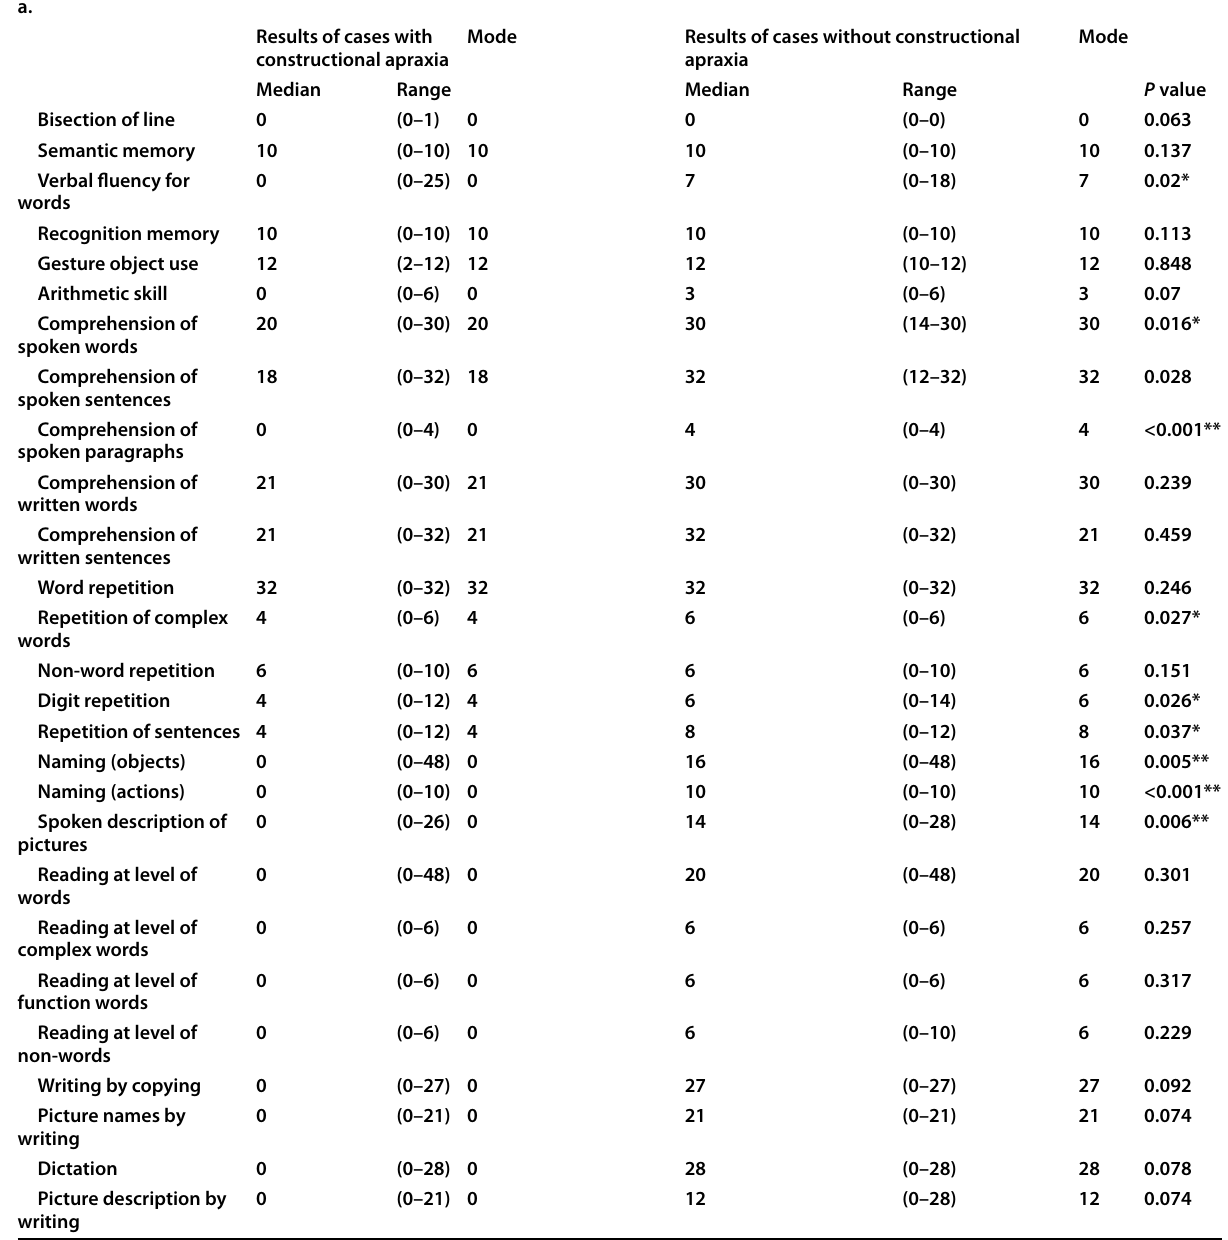
Table 3 Comparison between patients with constructional apraxia and without constructional apraxia regarding scores of aphasia test. Table 3 (a) that was statistically analyzed using the median shows that there was a significant difference between patients with constructional apraxia and patients without constructional apraxia in the scores of aphasia test in word fluency, spoken word and paragraph comprehension, repetition of complex words, digit strings and sentences, naming sub-items, and spoken picture description. Table 3 (b) that was statistically analyzed using the mean reveals that there was a significant difference between patients with constructional apraxia and patients without constructional apraxia in the scores of aphasia test in spoken word comprehension, spoken sentence, and spoken paragraph comprehension repetition of digit string, sentence repetition, naming objects and actions, spoken picture description, reading words, writing copying and words, and